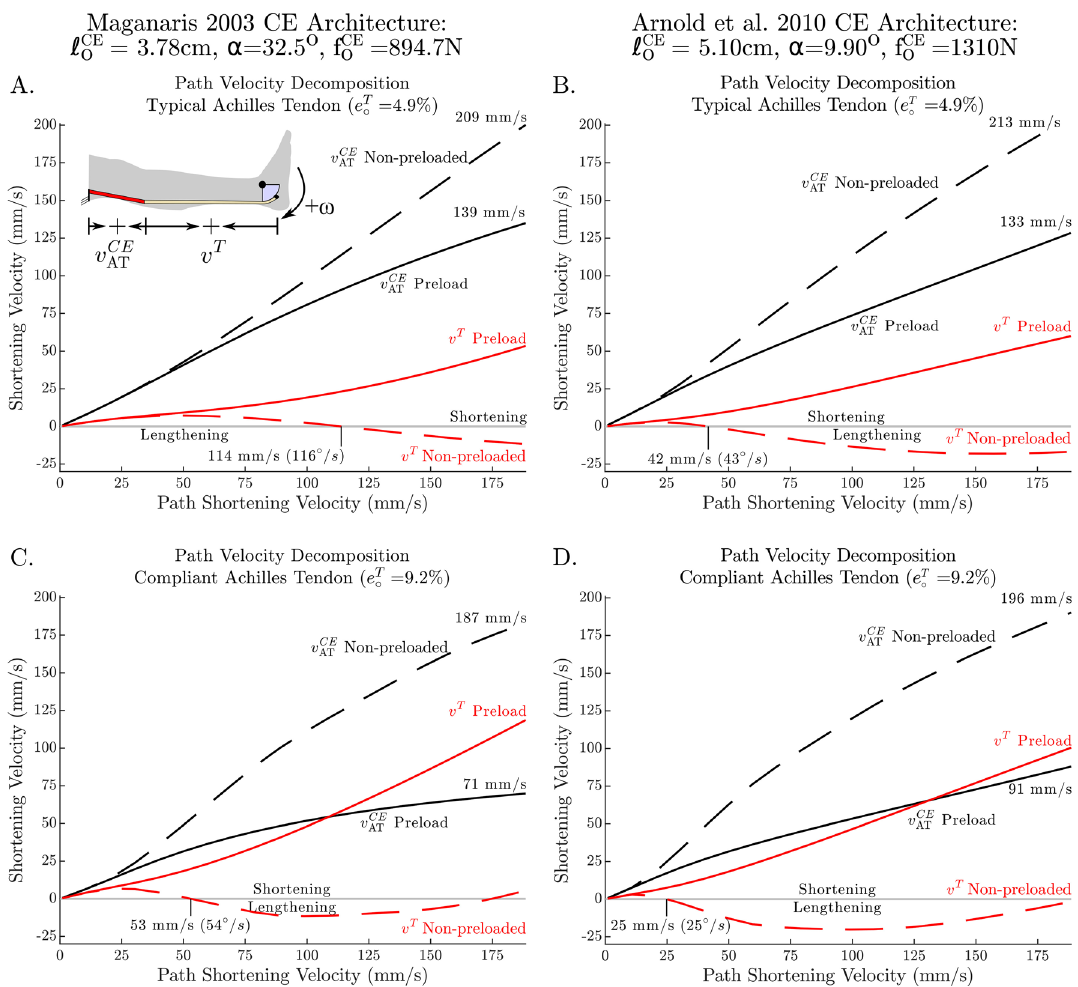
Figure 6. The effects of preload and tendon compliance on simulated T–ω–r shape are robust against changes in the architectural properties of the contractile element (CE). Simulations produced using CE architectural data CE f CE from Maganaris 7 ( l o of 3.78 cm, α of 32.5°, and o of 894.7 N) and Arnold et al. 16 ( f